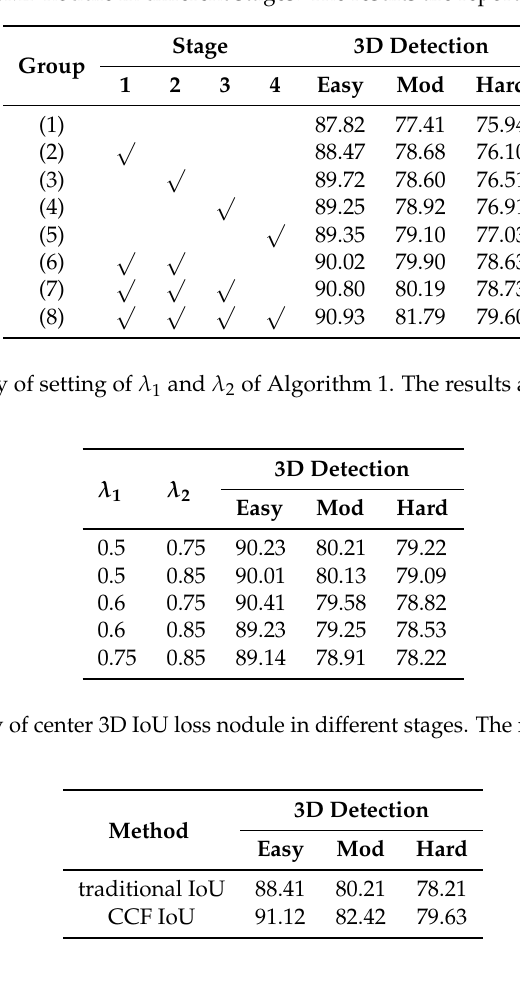
Table 1. Ablation study of CMF nodule in different stages. The results are reported on the KITTI validation set.